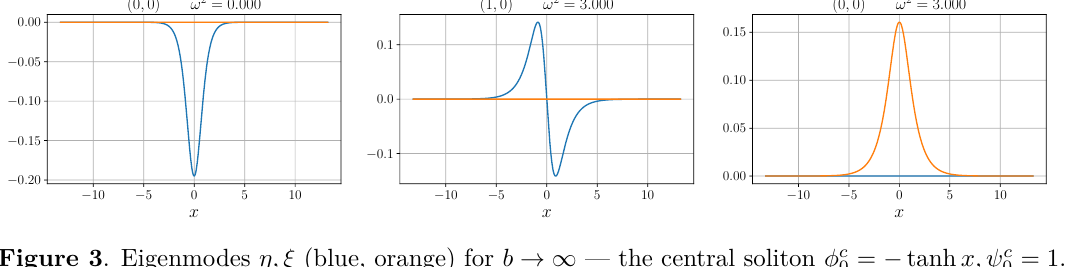
Figure 3 . Eigenmodes η, ξ (blue, orange) for b → ∞ — the central soliton φ c